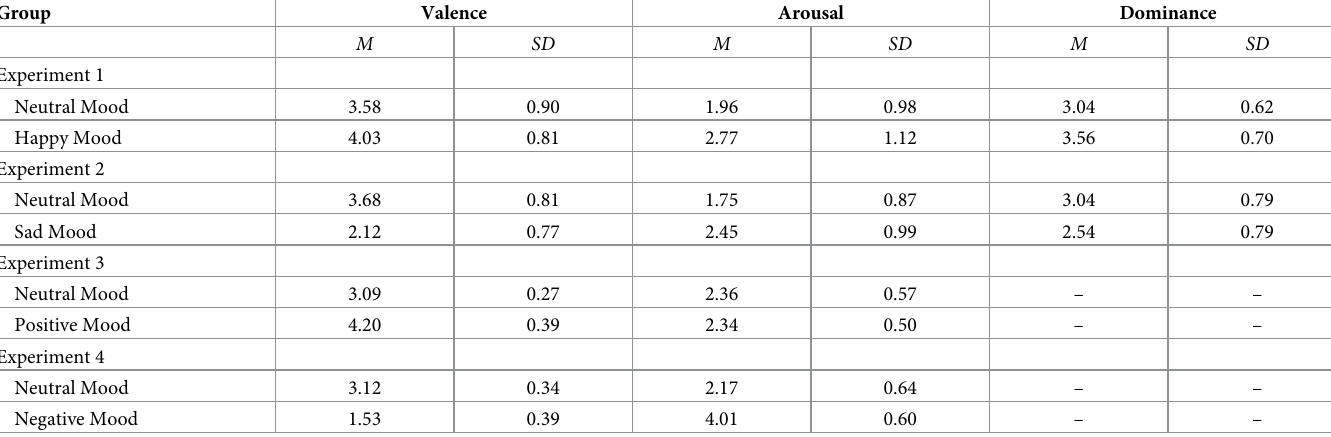
The five-point bipolar scales of SAM were used. SAM scores can range from unhappy (1) to happy (5) for valence, from calm (1) to excited (5) for arousal, and from controlled (1) to dominant (5) for